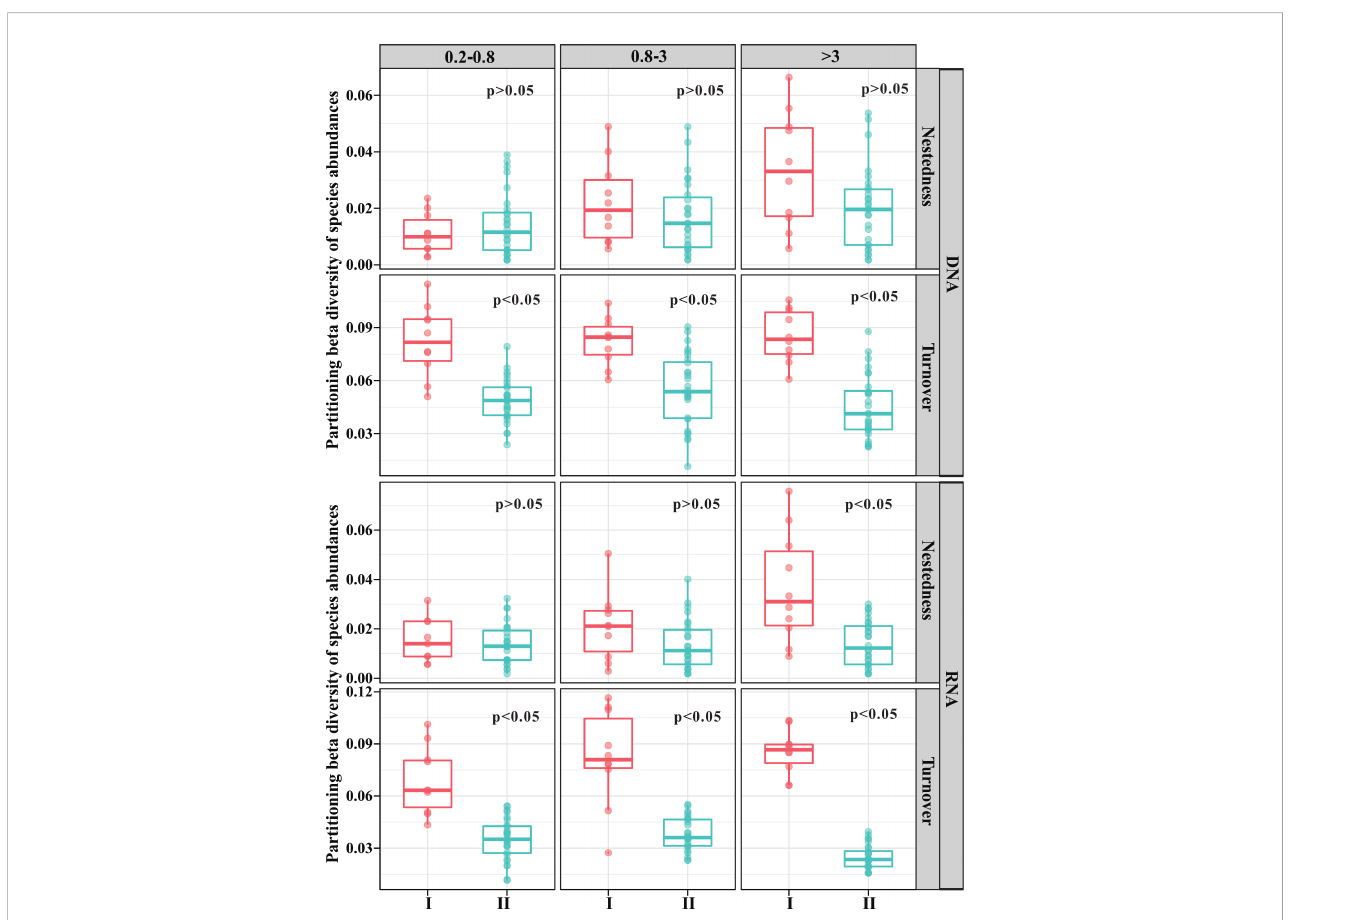
FIGURE 3 Pairwise turnover and nestedness component of b -diversity across incubation time. I, stabilization phase; II, strati fi cation